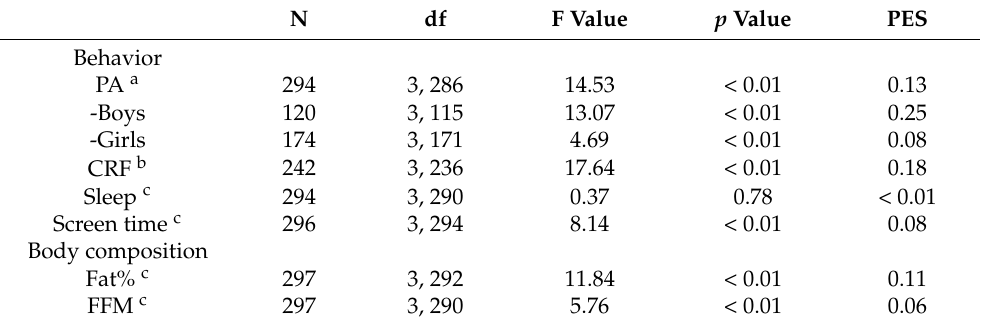
Table 2. Linear regression results with organized sport participation (OSP) as the dependent vari- able.